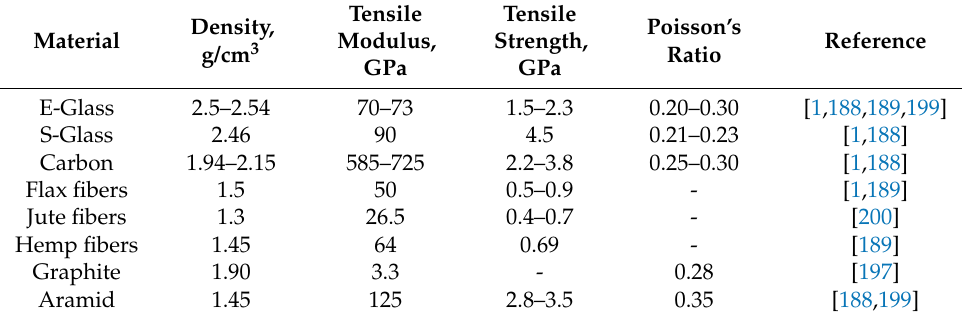
Table 2. Fibers used as reinforcement in thermoplastic